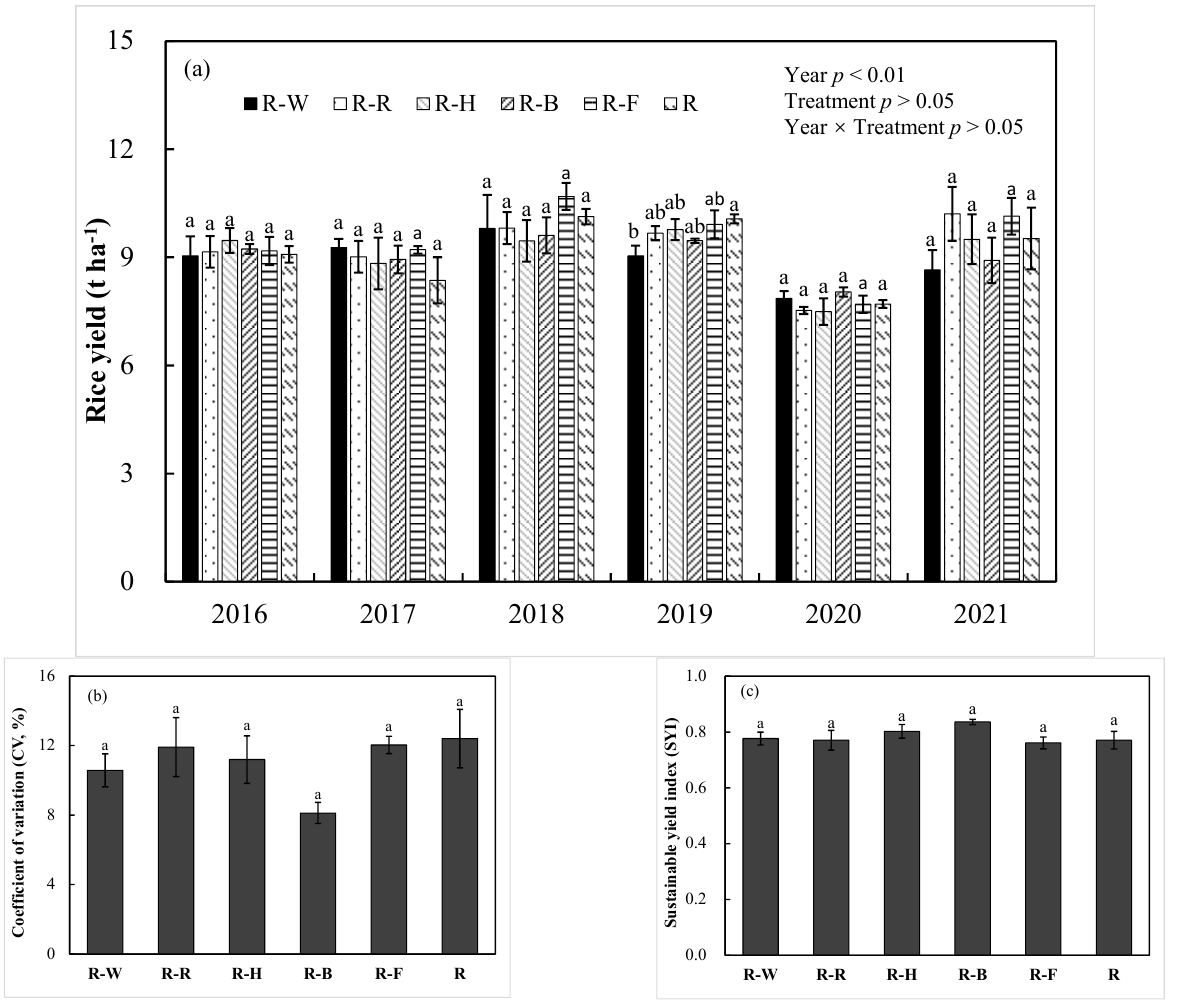
Figure 1. Effects of different cropping systems on rice yield and the yield stability: ( a ) rice yield; ( b ) coefficient of variation (CV); ( c ) sustainable yield index (SYI). Vertical bars represent the standard error ( n = 3) and different lowercase letters indicate significant differences among treatments ( p < 0.05). R – W, rice – wheat; R – R, rice – rape; R – H, rice – hairy vetch; R – B, rice – barley; R – F, rice – faba bean; R, rice – fallow. Table 3. Effects of different cropping systems on annual biomass and energy yield.